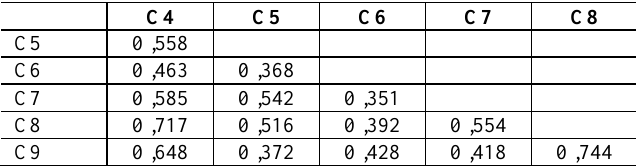
Table 2: Correlation coefficients for Culture (C)